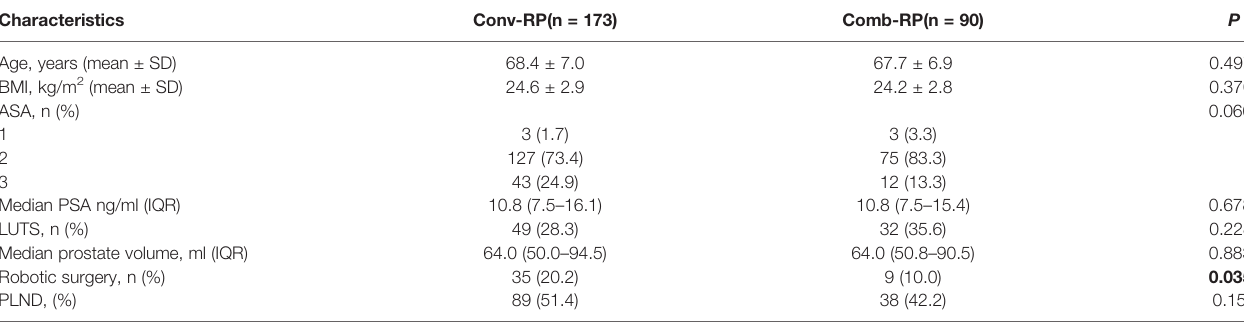
TABLE 1 | Baseline parameters of patients undergoing Conv-RP or